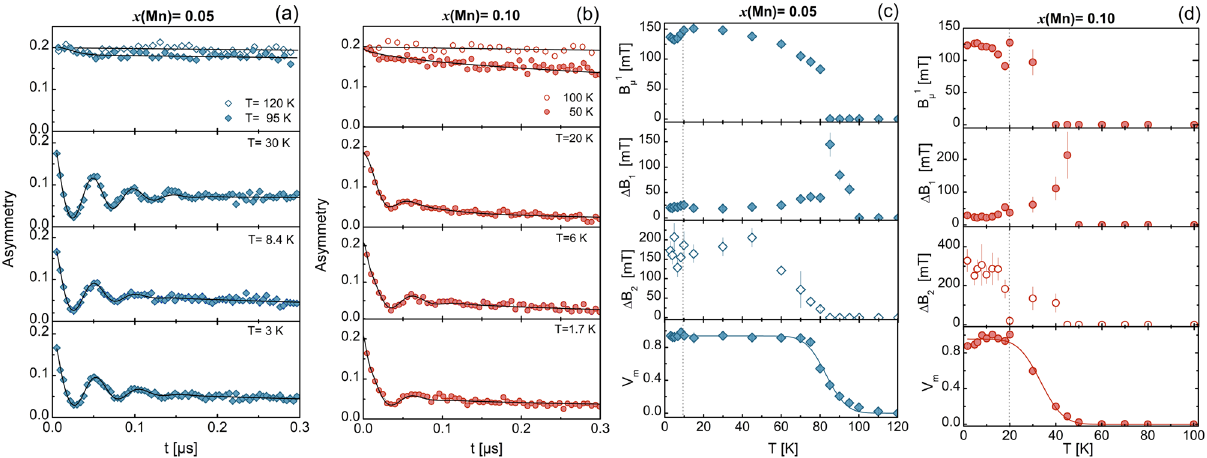
Figure 2. Short-time ZF- µ SR asymmetries at selected temperatures for the x = 0.05 ( a ) and x = 0.10 samples ( b ). Black lines represent numerical fits by means of Eq. (SI-2) (see SI). Parameters resulting from the fits to the time-dependent asymmetry for the x = 0.05 ( c ) and x = 0.10 ( d ) samples. Top and medium panels report the local magnetic fields B 1 µ and the local field widths ∆ B 1,2 for both samples. Bottom panels show the temperature dependence of the magnetic volume fraction. Here, the lines represent numerical fits by means of an erf model function. The vertical dotted lines in panels ( c , d ) indicate T ∗